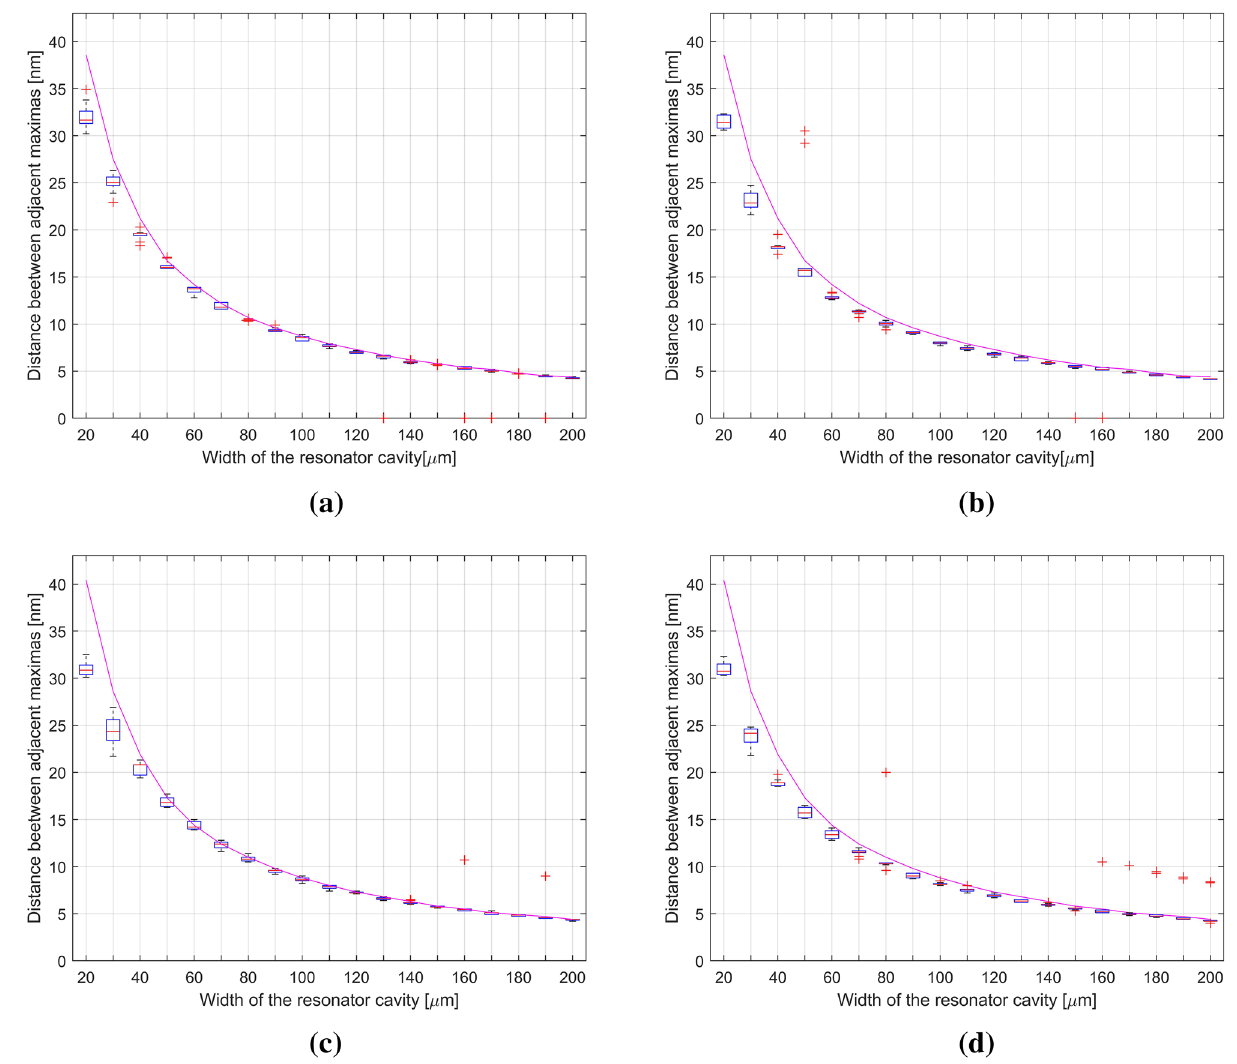
Figure 7. Distance between adjacent maxima in the signal using a 1310 nm source: ( a ) measured between the central and left peaks for silver mirror; ( b ) measured between the central and left peaks for SiN thin film; ( c ) measured between the central and right peaks for silver mirror; ( d ) measured between the central and right peaks for SiN thin film (where the magenta line is a theoretical model of data, red horizontal line is the mean value, red crosses are outliers).